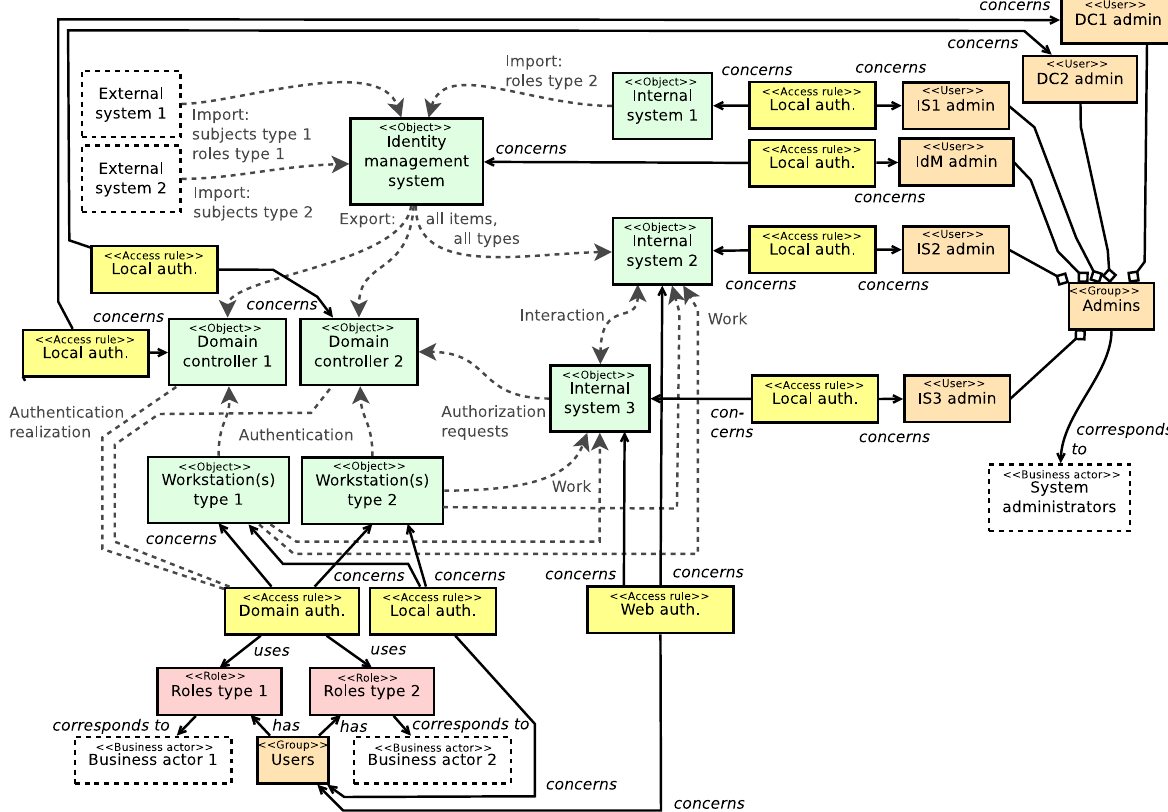
Figure 6. Model of Business case 1: Authorization in an IT landscape (simplified, anonymized). The dashed elements are not modeled according to the unified metamodel proposed in Section